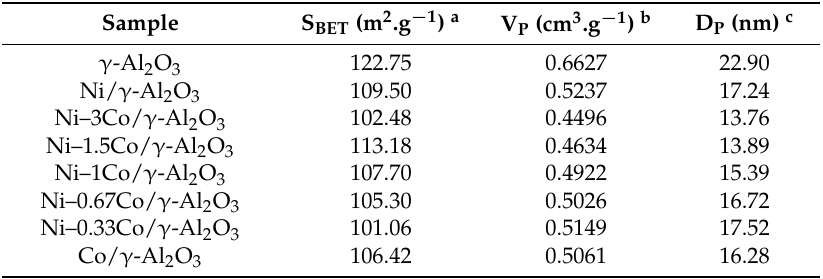
Table 1. BET surface area, pore volume, and pore diameter.